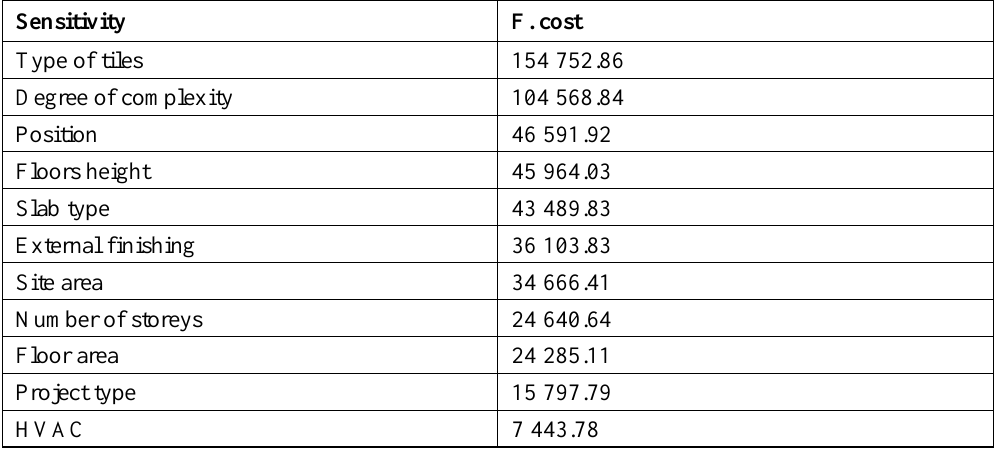
Table 7. Results of the sensitivity analysis about mean (developed by the author)